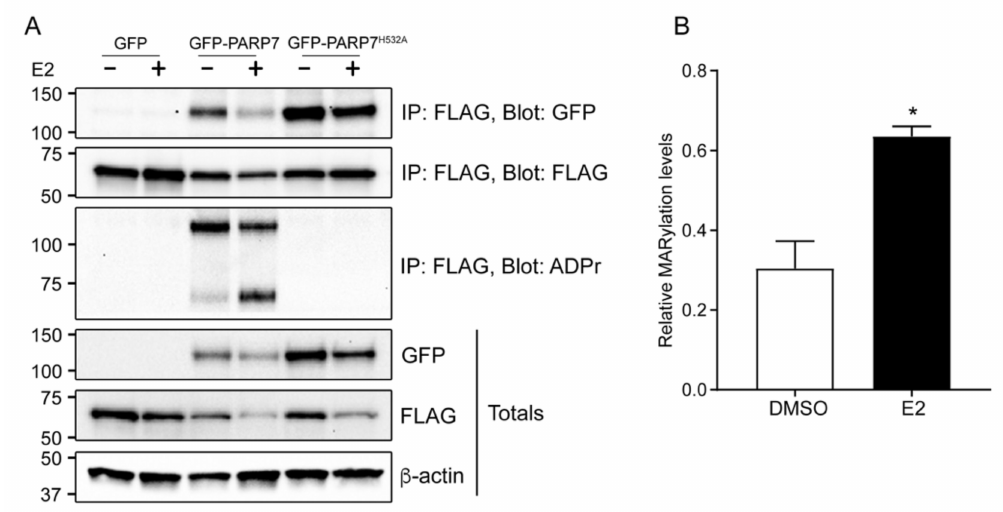
Figure 5. Overexpressed PARP7 mono-ADP-ribosylates overexpressed ER α . ( A ) PARP7 and its catalytically inactive mutant interacts with ER α in COS-1 cells when treated with DMSO and E2. COS-1 cells were transfected with FLAG-ER α , and either GFP, GFP-PARP7 or GFP-PARP7 H532A , and treated with DMSO or E2 for 24 h. Co-immunoprecipitation was carried out with anti-FLAG. The membranes were incubated with anti-FLAG, anti-GFP, and anti-ADP-ribose. Both wildtype PARP7 and ER α are mono-ADP-ribosylated, but not by the catalytically inactive PARP7 H532A mutant. ( B ) Relative MARylation levels of immunoprecipitated FLAG-ER α in the presence of GFP-PARP7 after treatment with DMSO or E2 for 24 h. Quantification of protein bands normalized to β -actin revealed that mono-ADP-ribosylation of ER α was significantly ( p < 0.05) increased upon treatment with E2 as indicated by an asterisk